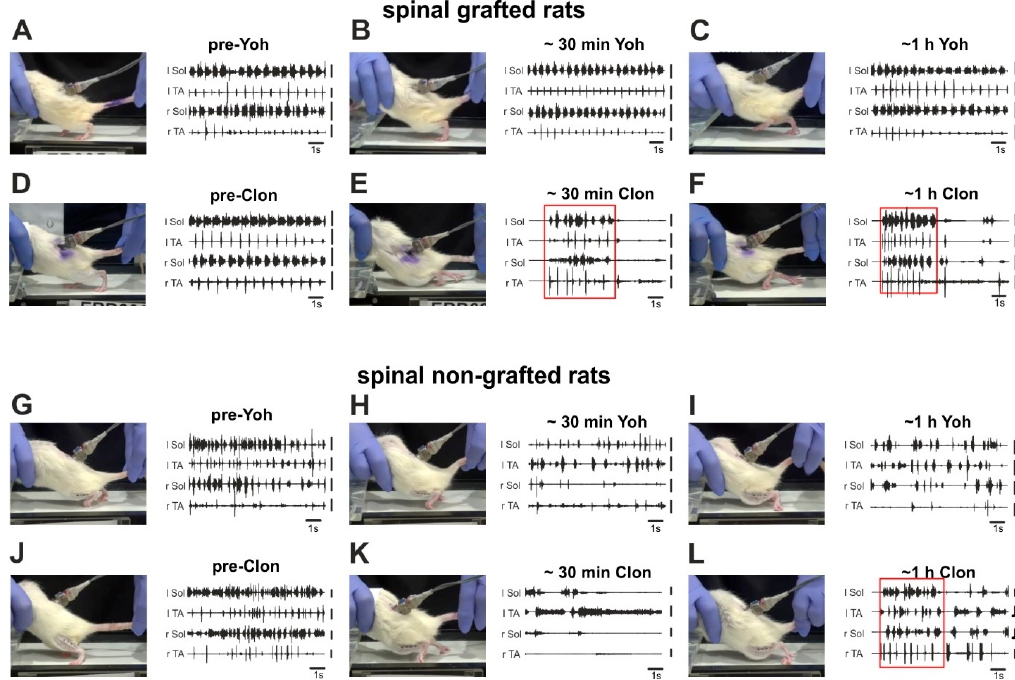
Figure 5. The top two panels present video frames of the spinal grafted rats with a typical posture and accompanied EMG activity recorded during the locomotor performance on the treadmill ( A – F ) before and after application of yohimbine (antagonist of α 2 adrenergic receptors) that substantially improved locomotor hindlimb movements ( A – C ); before and after application of clonidine (agonist of α 2 adrenergic receptors) resulting in deterioration of body weight support and both hindlimbs dragging over the moving treadmill belt ( D – F ). The bottom two panels ( G – L ) present video frames of the spinal non-grafted rats with a typical posture and accompanied EMG activity recorded during the locomotor performance on the treadmill before and after application of yohimbine ( G – I ) that was not accompanied by any visible changes in limb performance and before and after application of clonidine ( J – L ) resulting in substantial deterioration of already limited limb